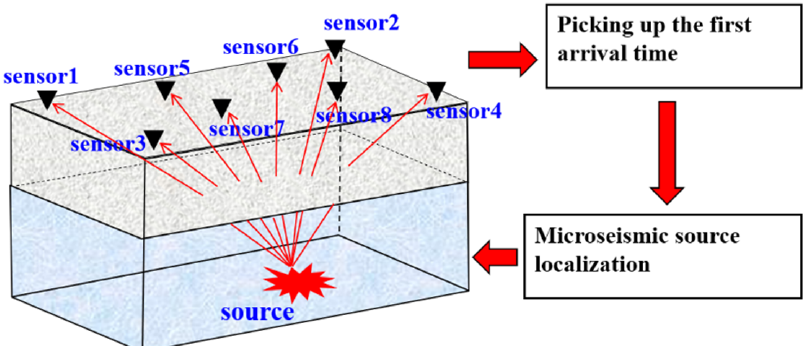
Figure 1. Schematic diagram of the microseismic monitoring system.